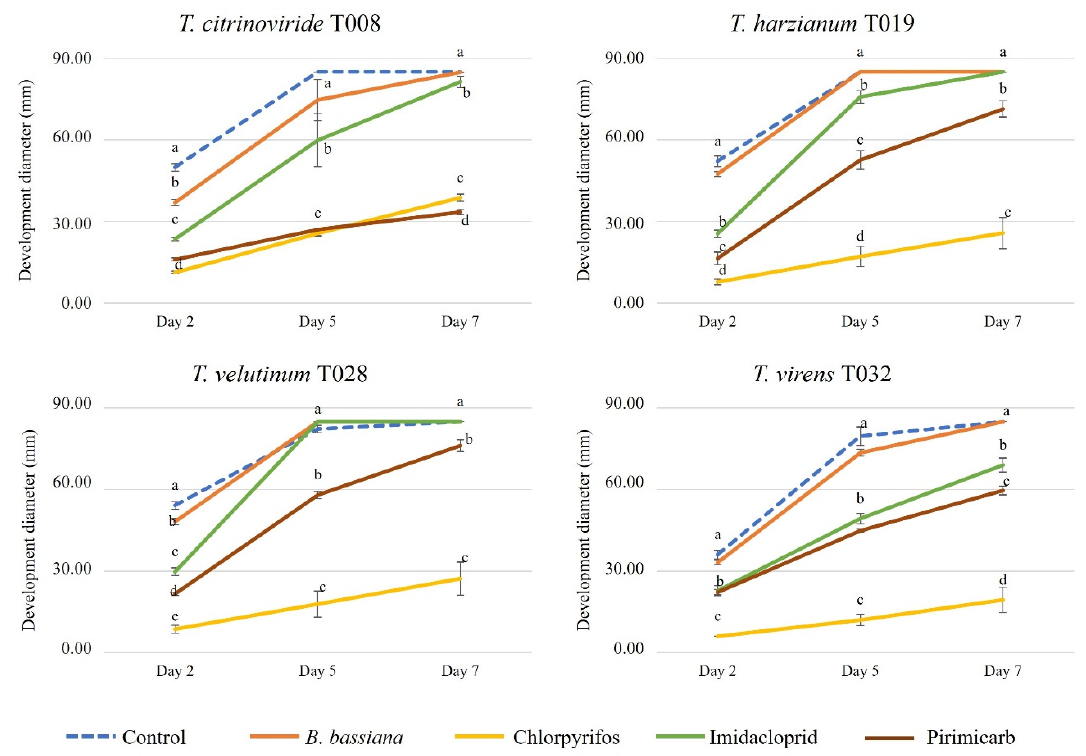
Figure 4. Development of autochthonous Trichoderma strains (diameter of growth, mm) in media with synthetic insecticides and the entomopathogenic fungus Beauveria bassiana at 2, 5 and 7 days after inoculation. Blue color: control Petri dish. Orange color: Beauveria bassiana 22%. Yellow color: Chlorpyrifos 48%. Green color: Imidacloprid 20%. Brown color: Pirimicarb 20%. The concentrations of each pesticide are specified in Table 2. Upper and lower error bars are represented and indicate standard error of the mean showing the accuracy of the calculations. Different letters indicate significant differences between synthetic insecticides and an entomopathogenic fungus (ANOVA, LSD, p < 0.05).